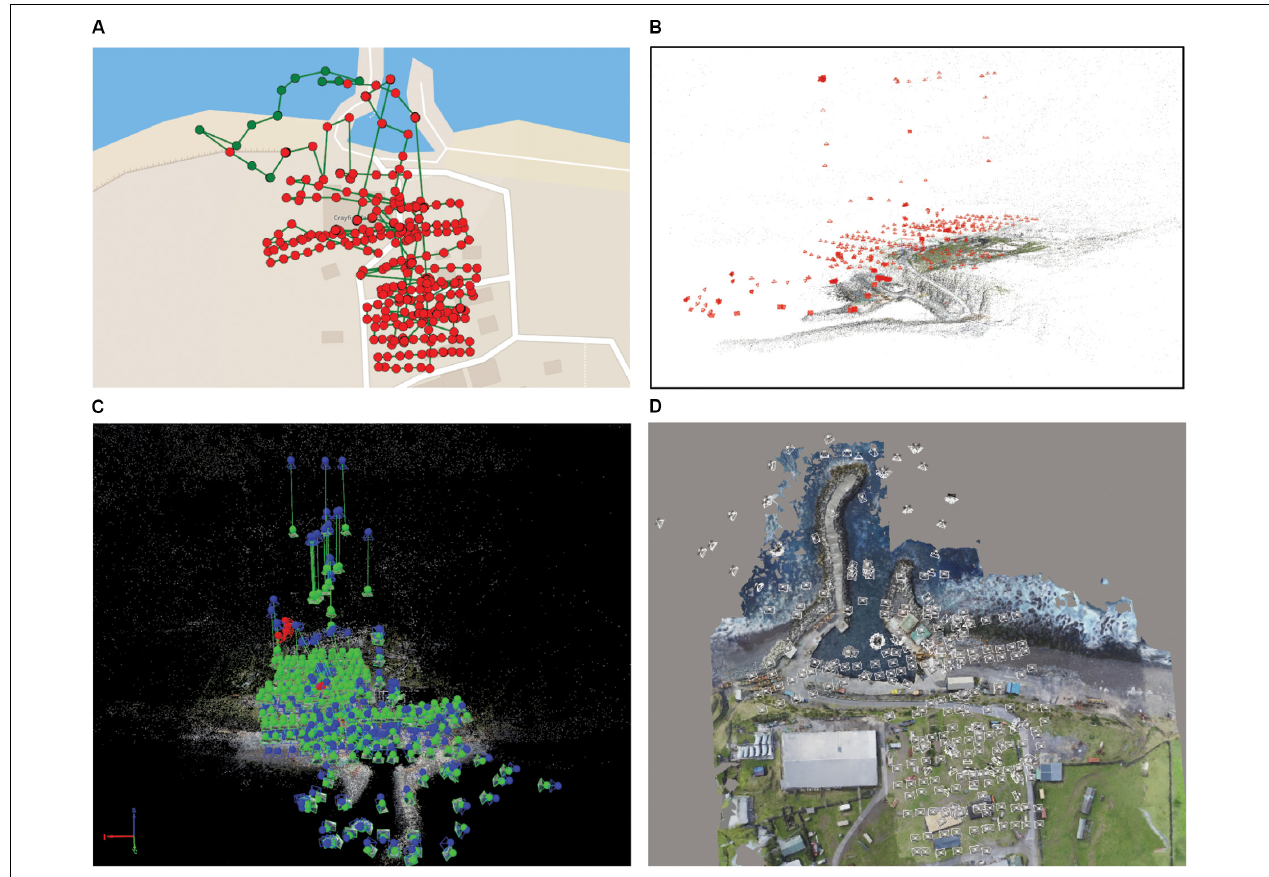
FIGURE 4 | (A) Flight missions overlaid on OSM in 2D. (B) Perspective view shows different altitudes and image perspectives. (C) Image positions after bundle block adjustment. (D) Orthophoto with overlaid image